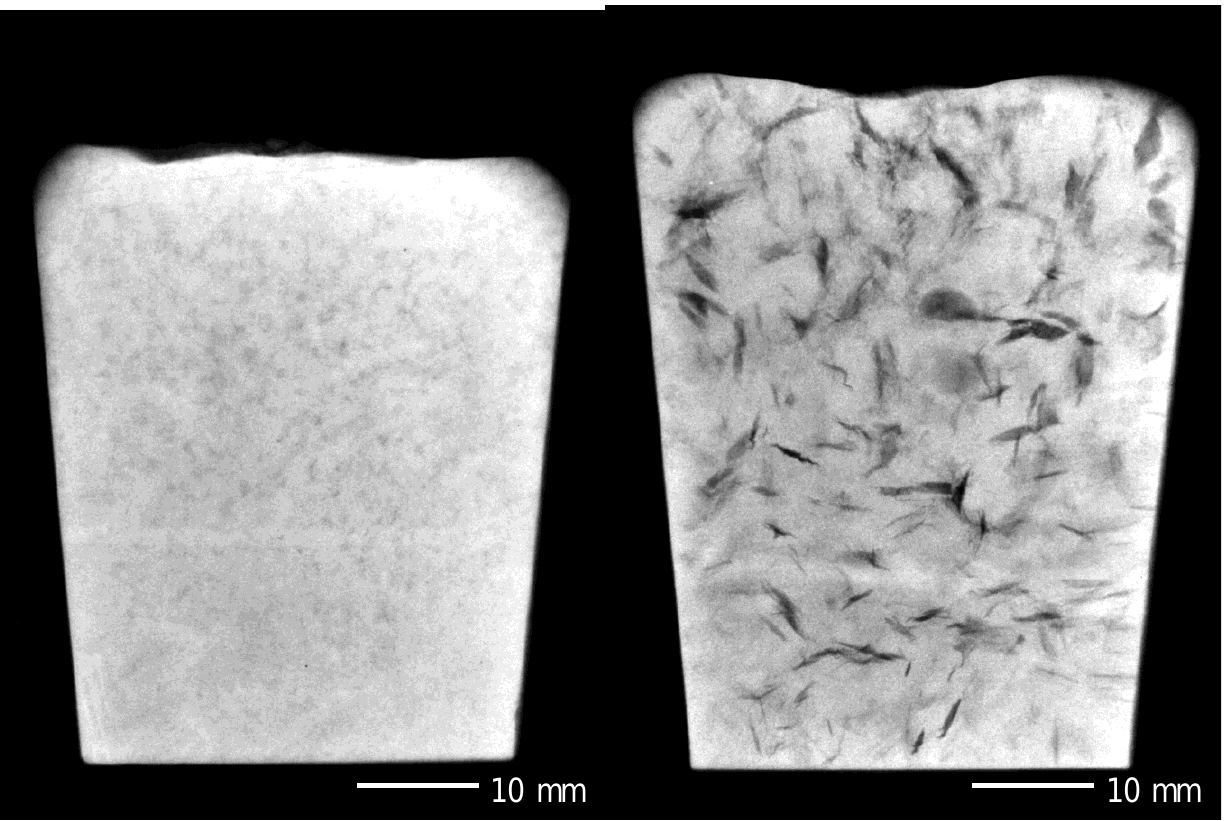
Figure 5. A radiographic image of a divided sample of the same A356 Al alloy poured into two 35 mm diameter stainless steel cups [41]. On the left the sample solidified under atmospheric pressure displays faint images of compact bifilms. On the right the bifilms have been opened up and straightened by subjecting the sample to a pressure of a tenth of an atmosphere, expanding the residual air between the opposite halves of the bifilm. Note the size and density of bifilms in this sample (Courtesy Simon